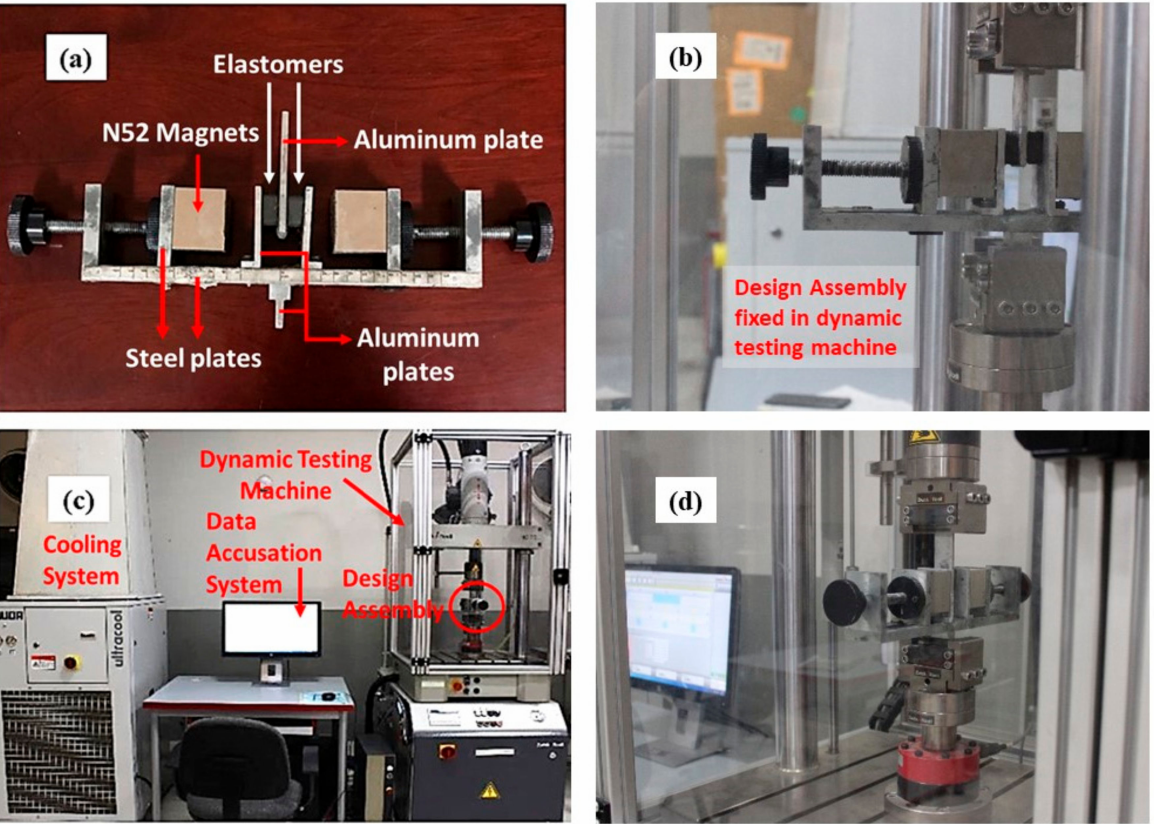
Figure 5. Experimental assembly and set up for dynamic testing ( a ) magnetic assembly holding magnets and elastomers ( b ), ( d ) experimental assembly fixated in the dynamic testing machine ( c ) Zwick/Roell Servohydraulic testing machine used for dynamic